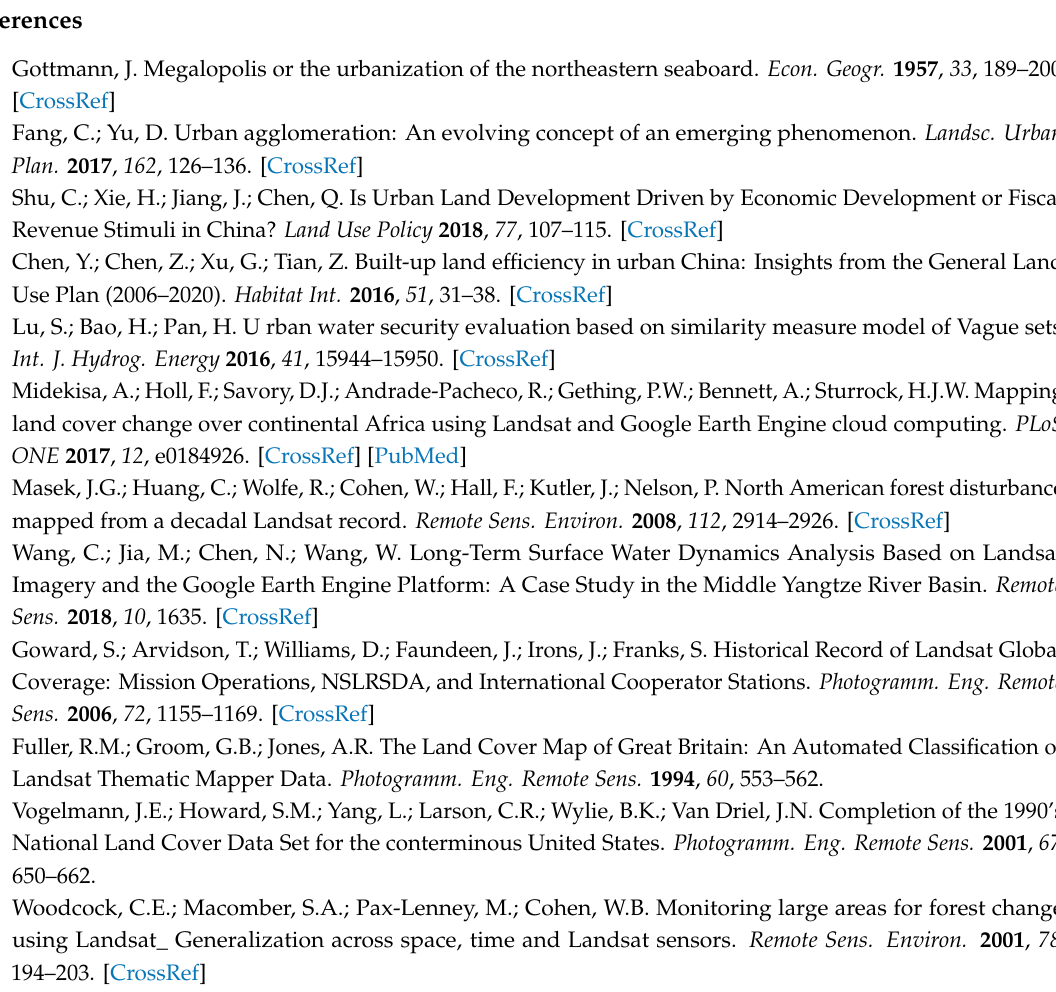
Table S3: Correlation coe ffi cient of land use change and its driving factors in